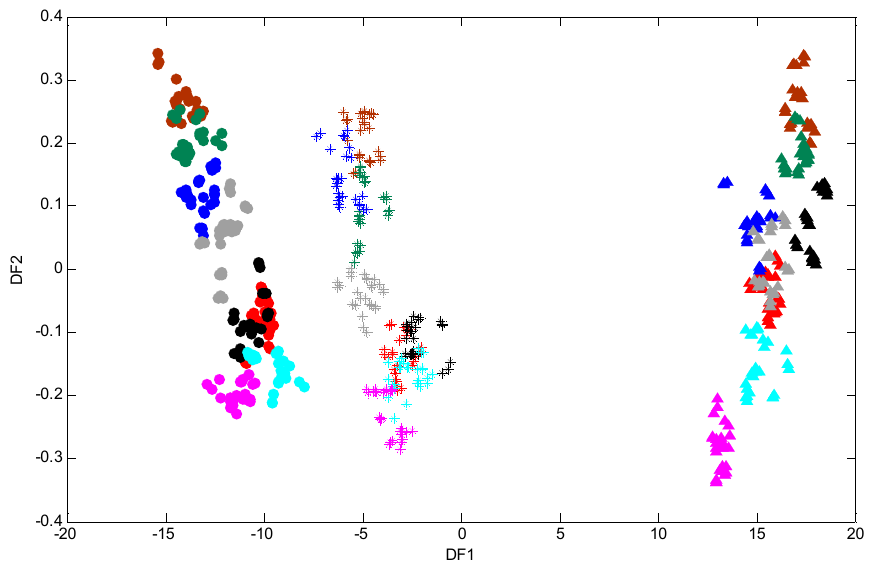
Figure 3. PC-DFA scores plots of FT-IR data of P. putida DOT-T1E strains in LB medium supplemented with or without 7 mM magnesium and 3 mM calcium in the absence and presence of 0.05% ( v/v ) toluene. Symbols represent different strains: P. putida DOT-T1E wild-type (stars), P. putida DOT-T1E-PS28 (closed circles), and P. putida DOT-T1E-18 (closed triangles). PCs 1-30 with a total explained variance (TEV) of 99.92% were used for the DFA. Colour coding: control with no toluene (red), cells without toluene in the presence of 7 mM Mg 2+ (brown), 3 mM Ca 2+ (black), mixed 7 mM Mg 2+ and 3 mM Ca 2+ (green), cells challenged with 0.05% ( v/v ) toluene in the presence of 7 mM Mg 2+ (dark blue), 3 mM Ca 2+ (light blue), mixed 7 mM Mg 2+ and 3 mM Ca 2+ (grey), and cells with 0.05% ( v/v ) toluene in the absence of divalent cations (pink).